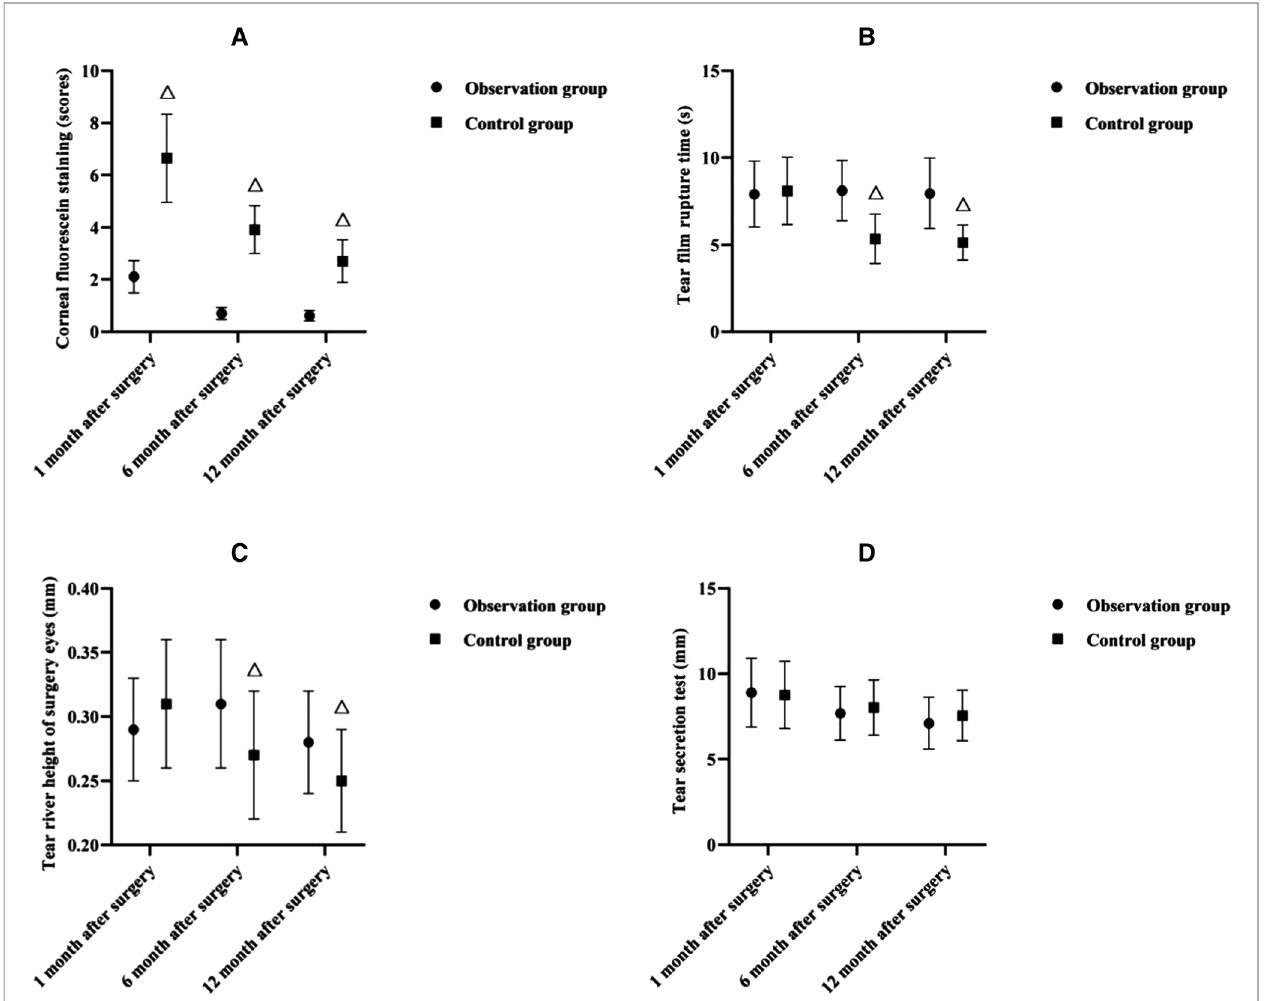
FIGURE 2 | Comparisonofocularsurfacestatusbetweentwogroupsineachmonthaftersurgery( (cid:1) x + s ).Note:( A )Corneal fl uoresceinstaining(scores).( B )Tear fi lmrupture time (s). ( C ) Tear river height of surgery eyes (mm). ( D ) Tear secretion test (mm). Note: Compared with the observation group at the same time, △ p